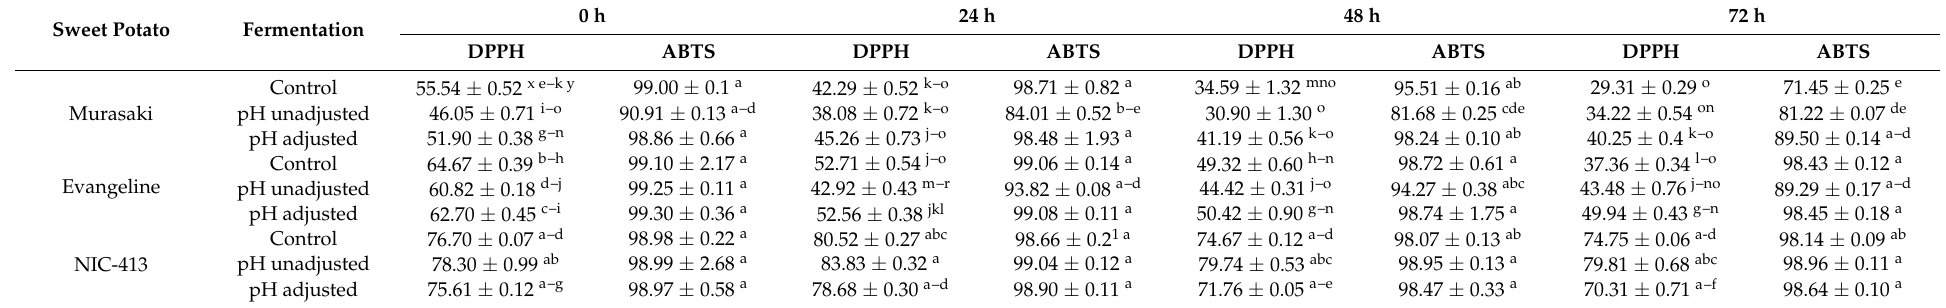
Table 2. Total antioxidant activity (DPPH and ABTS free radical scavenging assay) of unfermented and fermented (pH adjusted and unadjusted) sample of three sweet potato samples ( n = 12) at 0, 24, 48, and 72 h fermentation time